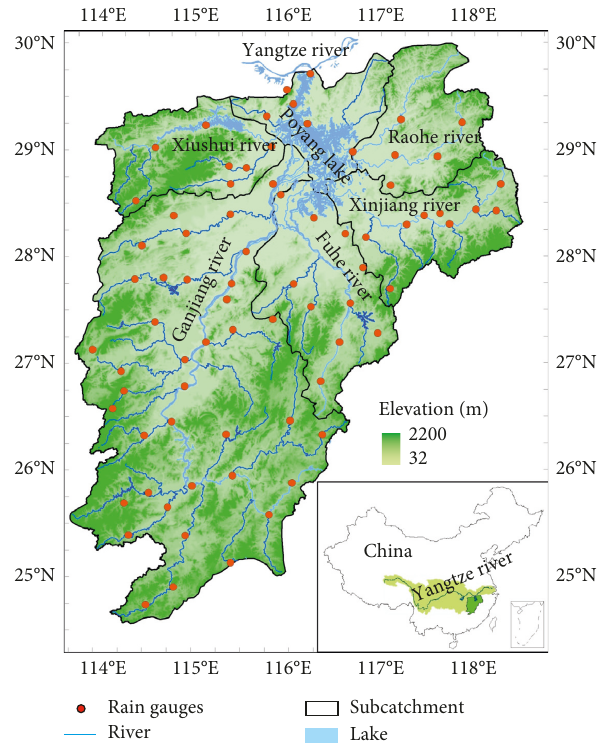
Figure 1: Location of study area and the distribution of rain gauges (reproduced from Li and Ye [40], under the creative commons attribution license/public